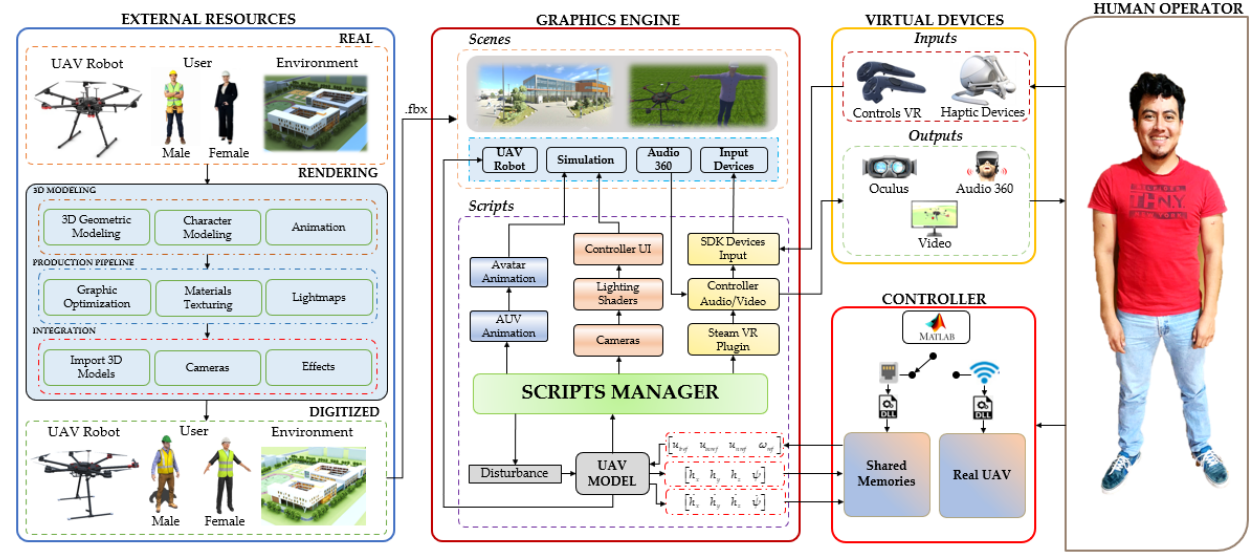
Figure 2. Proposed outline of the virtual simulator.